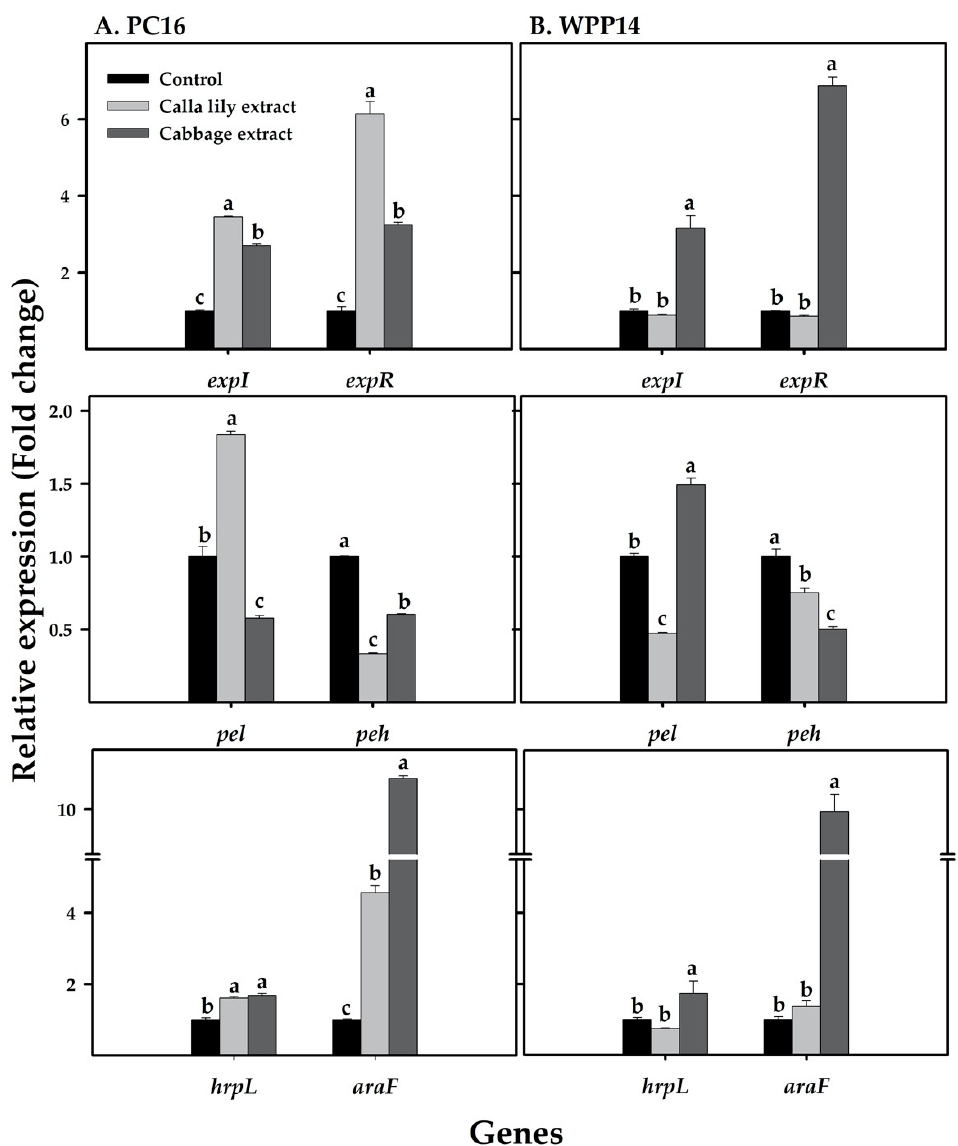
Figure 8. Expression levels of virulence-related genes in Pectobacterium strains ( A ) PC16 and ( B ) WPP14 in response to phenolic extracts from calla lily or cabbage leaves. The transcript levels of the examined genes were analyzed in DNA-free RNA from the bacterial strains PC16 and WPP14 after 8 h in LB medium with or without host extracts (control), at 28 ° C under continuous shaking (150 rpm). The expression levels of expI , expR , pel , peh , hrpL and araF were quantified relative to control using qRT-PCR. Experiments were repeated three times with three replicates showing similar trends. Bars represents mean ± SE of relative expression of each gene. Tukey–Kramer HSD test was used to test the differences, bars not labeled with the same letter (a–c) are significantly different from each other ( p < 0.05).